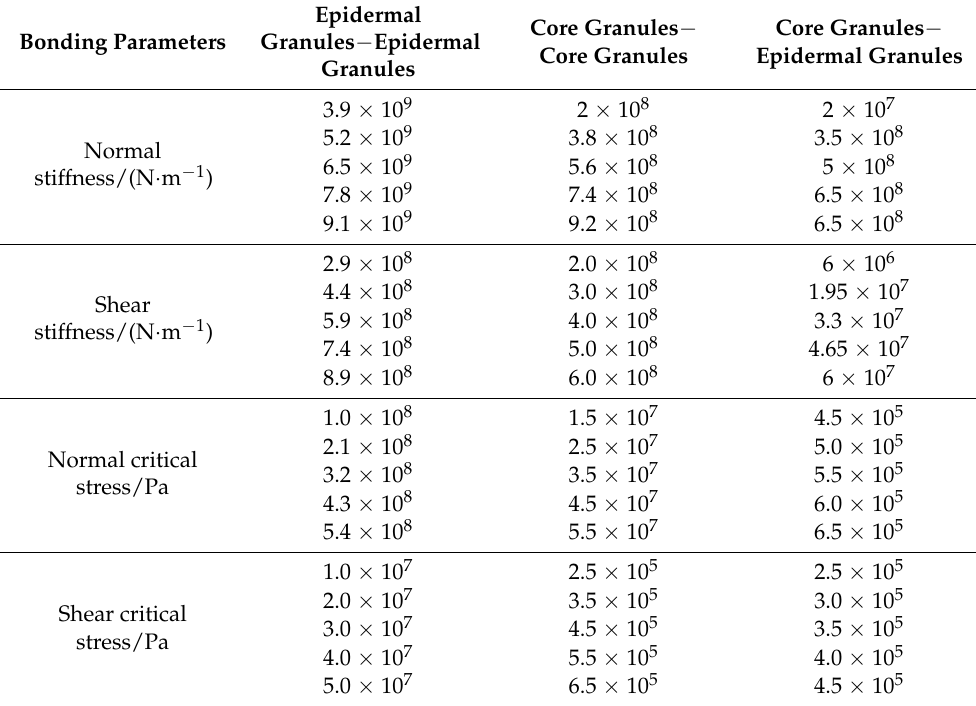
Table 1. Corn straw bonding parameters.